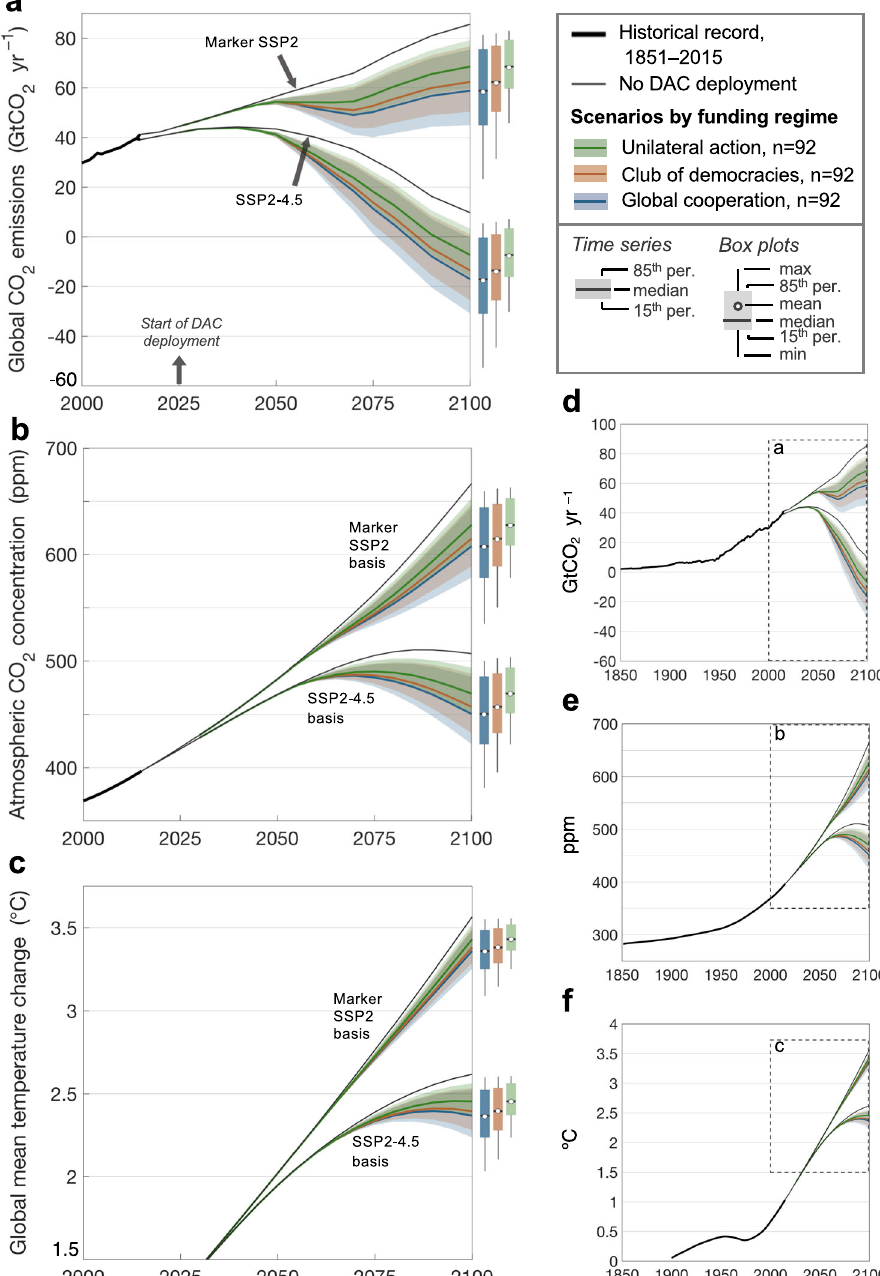
Fig. 4 Climate bene fi ts of net CO 2 removal assuming marker SSP2 and SSP2-4.5 emission futures. a Global CO 2 emissions. SSP emissions are from the SSP database version 2.0 (https://tntcat.iiasa.ac.at/SspDb; ref. 49 ). b Atmospheric CO 2 concentration. c Global mean temperature change relative to pre- industrial levels (1850 – 1900). d – f Trends beginning in 1850. Ribbons indicate the 15th and 85th percentile scenarios; solid lines indicate the median. Black lines show the case of no DAC deployment. Boxes show the 15th and 85th percentile scenarios in 2100; center line, median; dot, mean; whiskers, range. (Here we show SSP2, IPCC ’ s middle-of-the-road pathway; we include scenarios with a wider range of emissions — SSP1-2.6 and SSP5-8.5 — in Supplementary Fig.